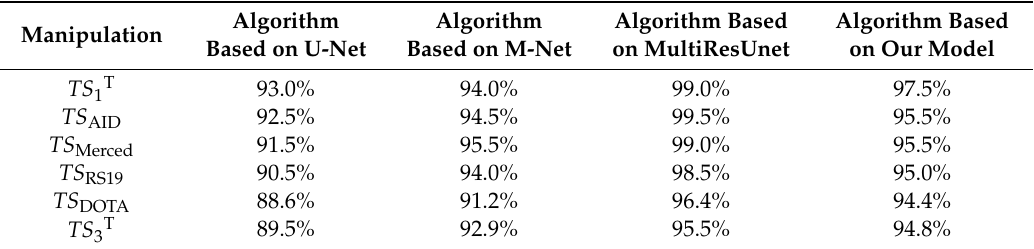
Table 6. Comparison of robustness test of adding noise ( T h is set to 0.05, di ff erent with Table